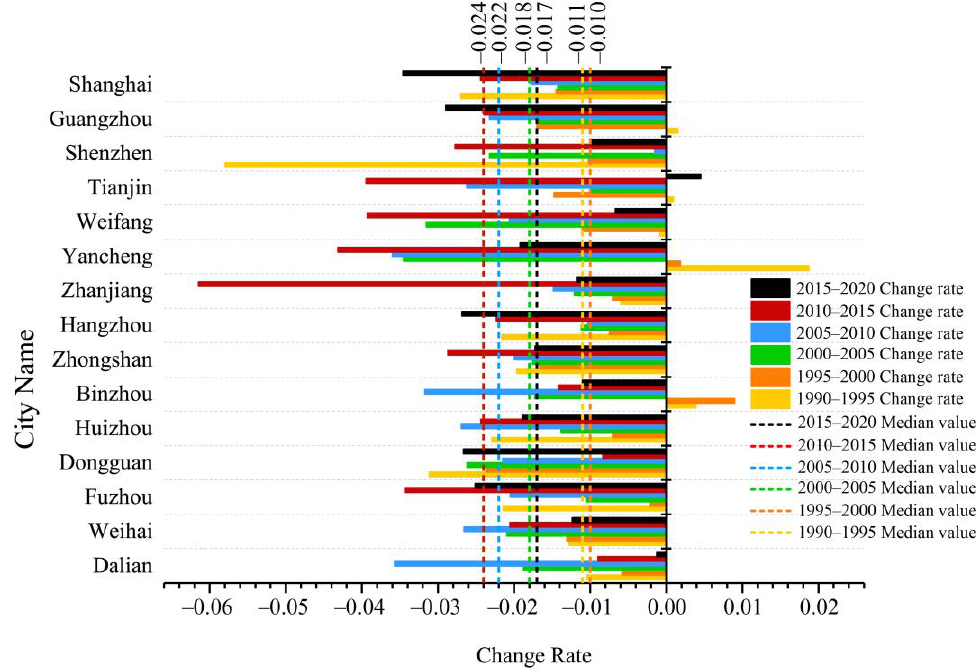
Figure 8. Bar distribution of mean change velocity of urban vulnerability values from 1990 to 2020.